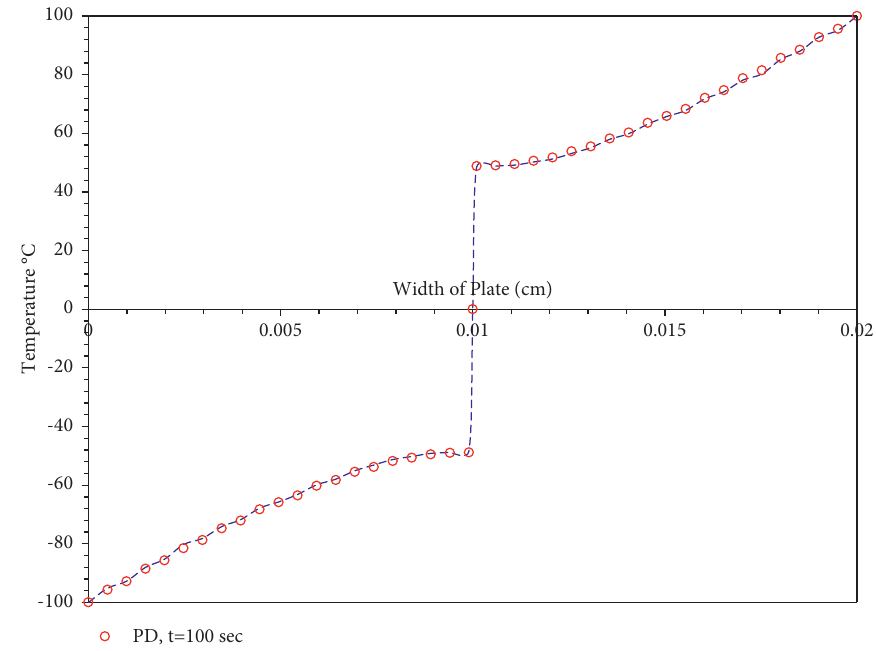
Figure 13: Comparison of PD and FEM solutions at t � 100s.